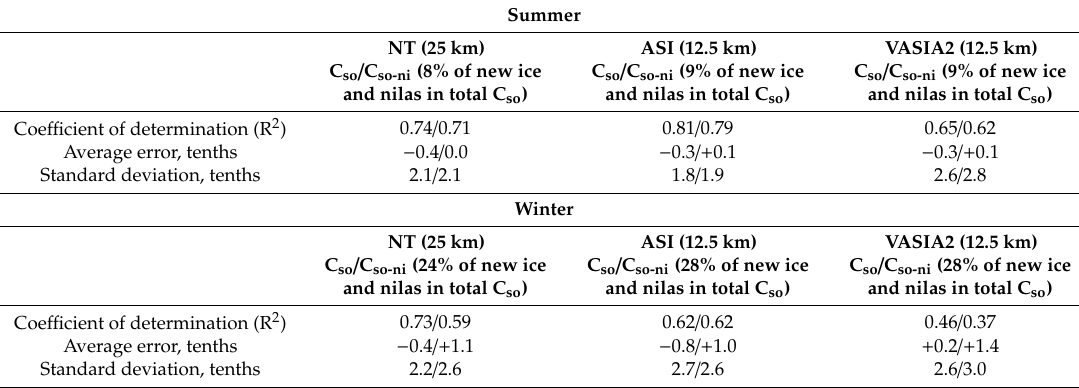
Table 2. Statistics of comparison between microwave satellite and ship data.